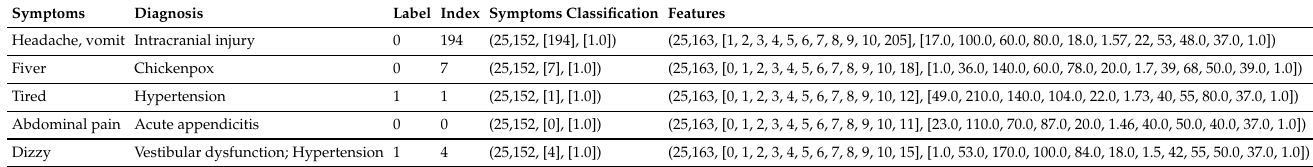
Table 2. Examples of data before training